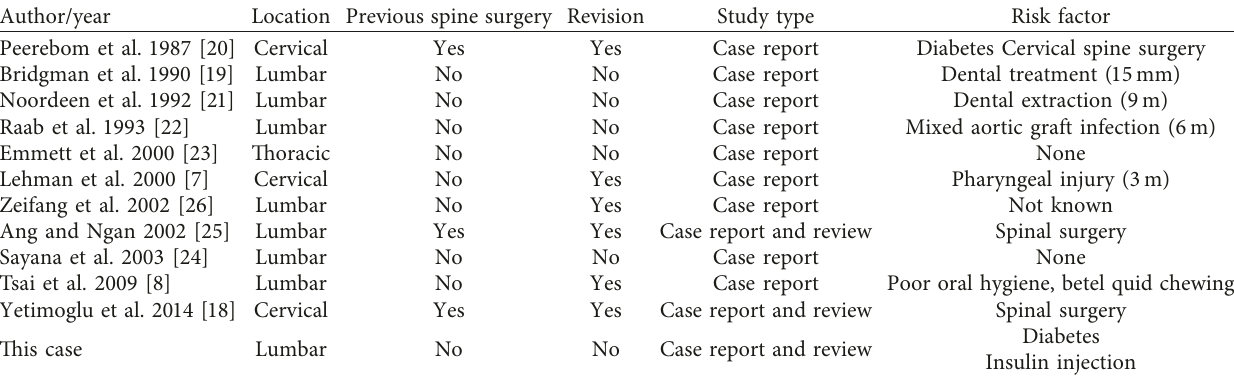
Table 1: Cases of vertebral osteomyelitis associated with Eikenella corrodens (mod according to